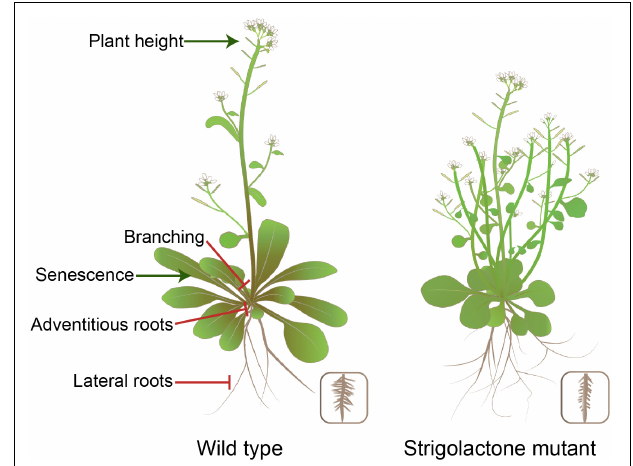
FIGURE 2 | Impact of SL production levels on plant morphology in Arabidopsis . SLs are involved in various developmental processes, including plant height, shoot branching, and root system